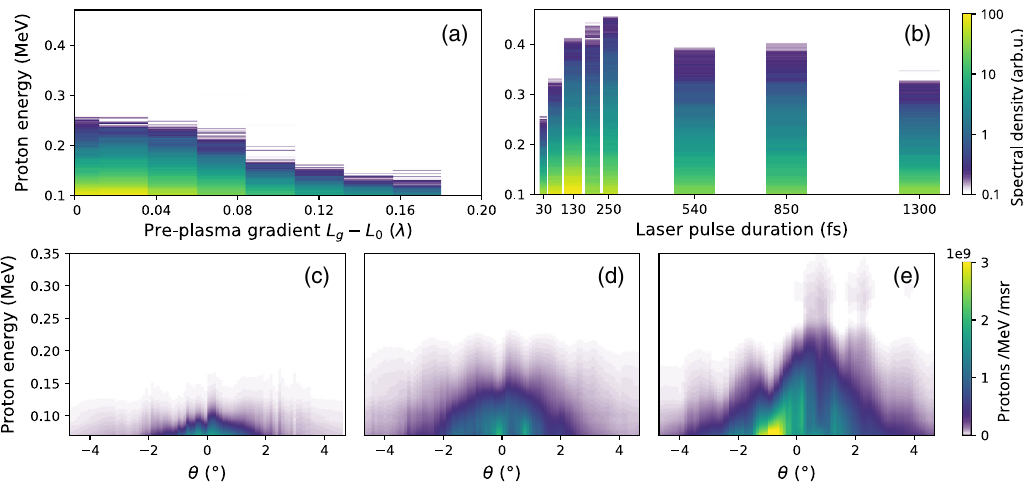
¼ 27 fs and varying plasma scale length (a), and for 0 las